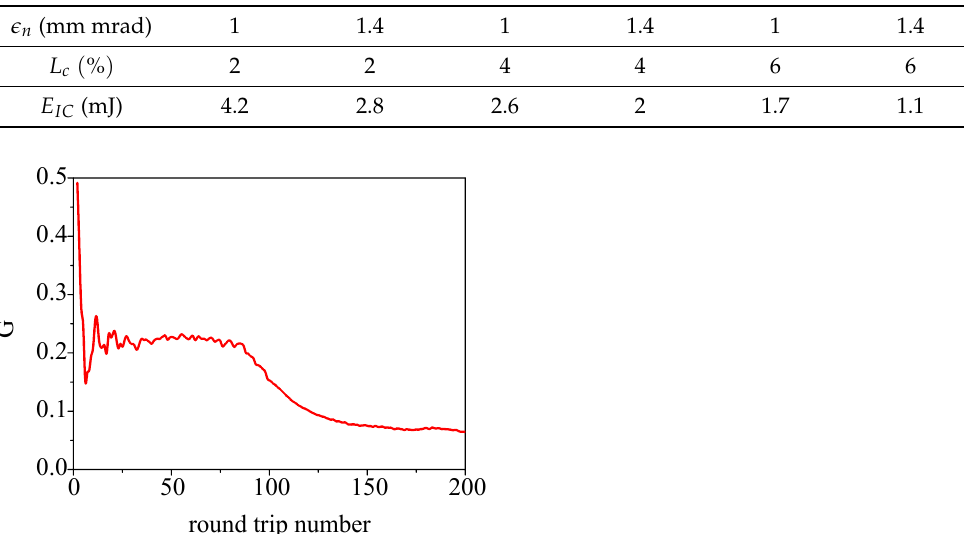
Figure 8. Intra-cavity radiation power profile P(W) vs. coordinate s(m) = t(s)c. Window ( a ): undulator period λ w = 3.5 cm; red curve: γ = 55.5, λ = 36 µ m; blue curve: γ = 81.5, λ = 13.2 µ m. Window ( b ): undulator period λ w = 4.5 cm; red curve: γ = 65, λ = 51.6 µ m; magenta curve: γ = 55.5, λ = 36 µ m; blue curve: γ = 86, λ = 15 µ m. Table 3. Intra-cavity radiation energy E IC for the different normalised emittance of the electron beam (cid:101) n and losses L c = L ext + L mirr + L lens .